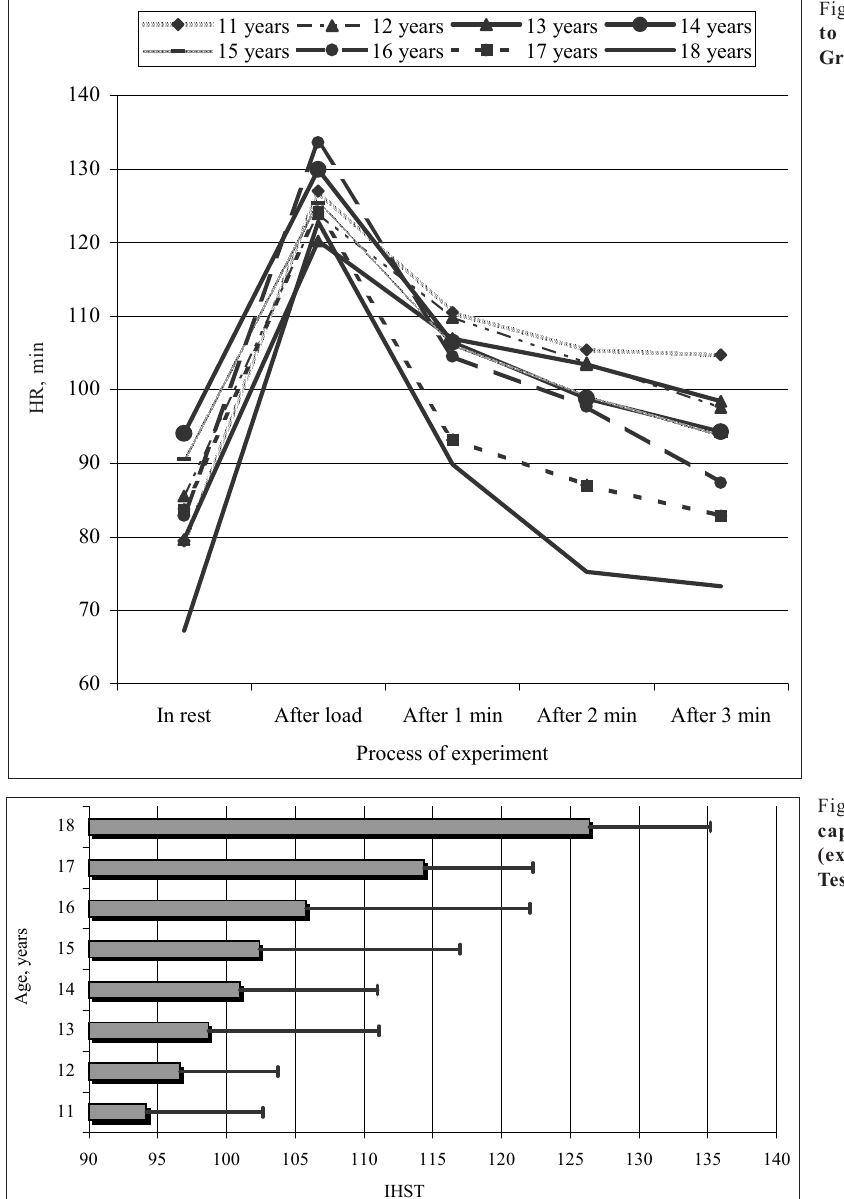
Fig. 1. Cardiovascular system response to the load of Harvard Step-Test in